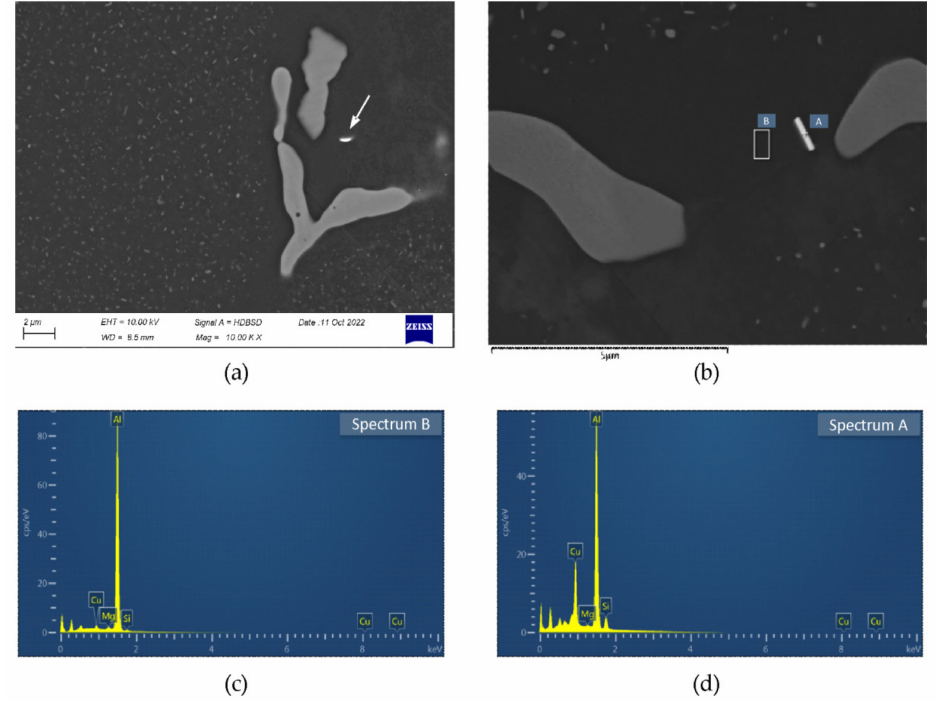
Figure 5. Alloy after homogenization with soaking at 475 ◦ C for 2 h + 530 ◦ C for 2 h + 545 ◦ C for 8 h and water quenching: ( a , b ) examples of small particles rich in Cu and Si; ( c , d ) spectra from panel